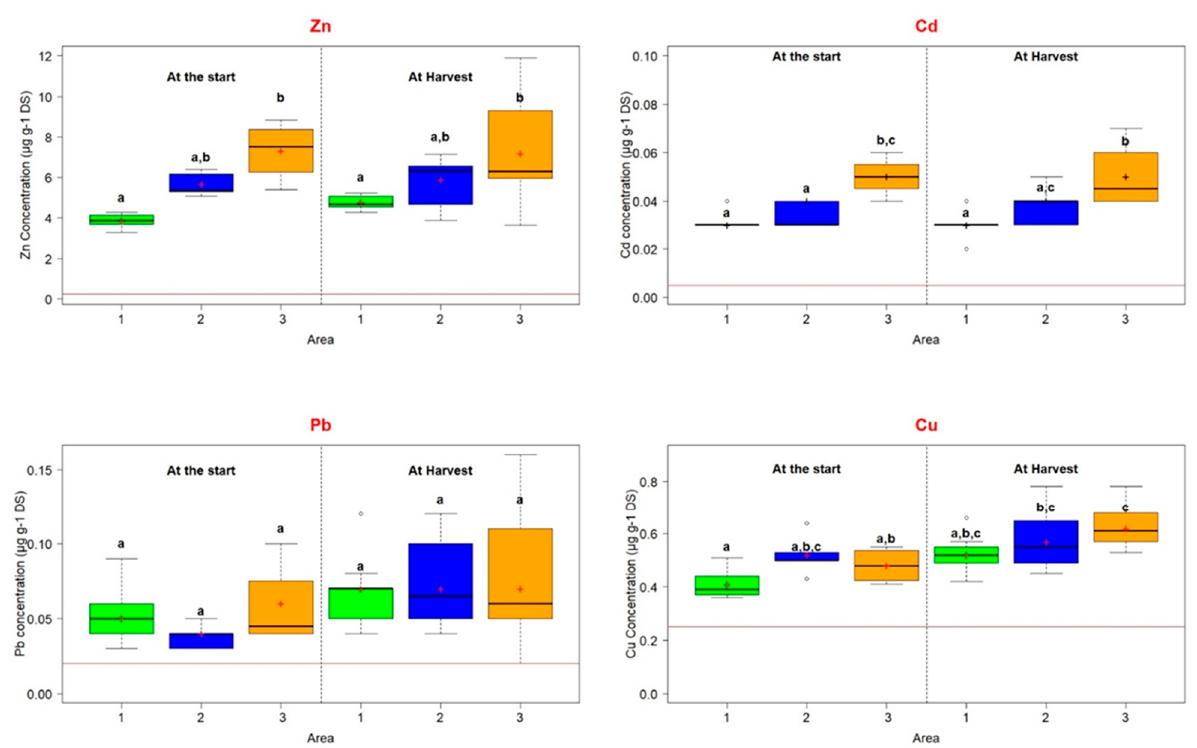
Figure 2. Sediment NH 4 NO 3 extractable concentration of Zn, Cd, Pb, and Cu in Area 1 (green), Area 2 (blue), and Area 3 (orange) at the start ( n = 5) and at harvest ( n = 10). The box plots indicate the median (black line), the 25 (lower bar), and the 75 (upper bar) percentiles; red cross = mean; the red line corresponds to the value references noticed in the ISO 19730:2008 € . Significant differences between conditions after Tukey HSD test are indicated by different letters at the level of α = 0.05.